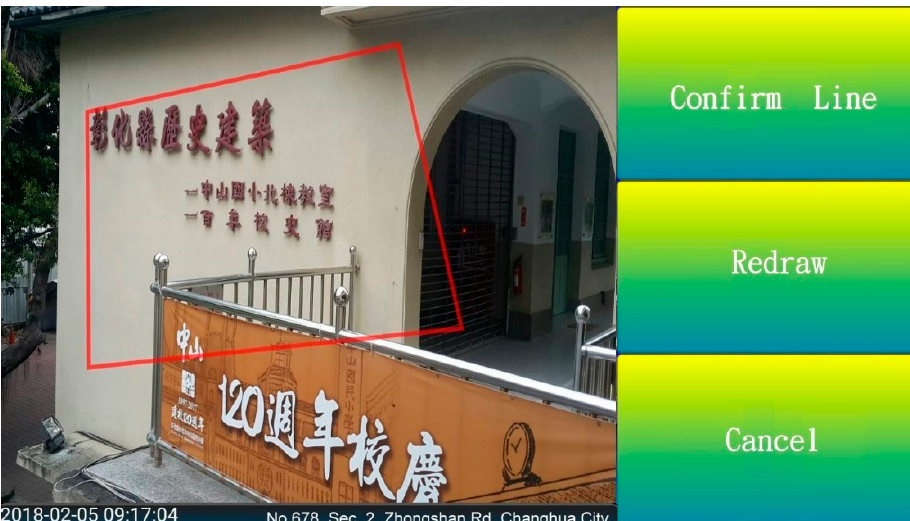
Figure 13. Marking out a certain area.